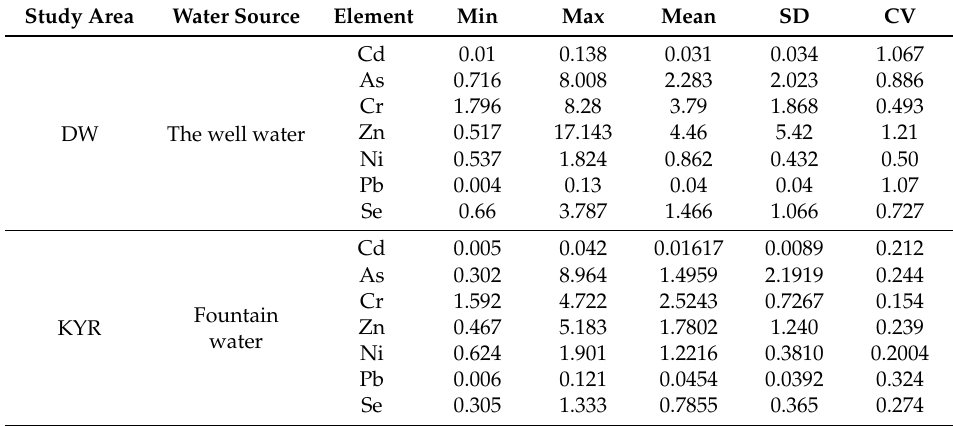
Table 4. Descriptive statistics analysis of the trace elements in the drinking water of the Bay Xinjiang